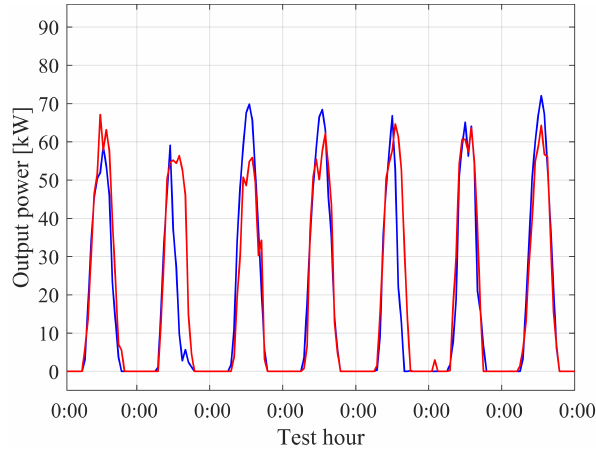
Figure 8. Predicted (red) and real (blue) value of output power in the mid of June 2018 by using the 2D-CNN approach with the combination of all the time series on 7-day test set (see Table 5, row 18, column 4).